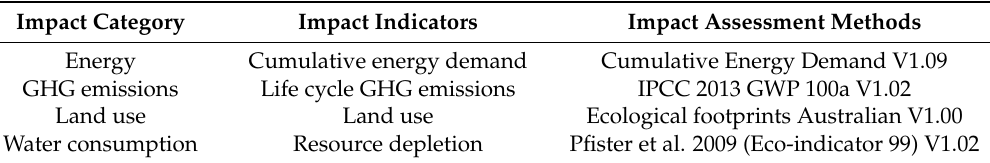
Table 4. Environmental Impact